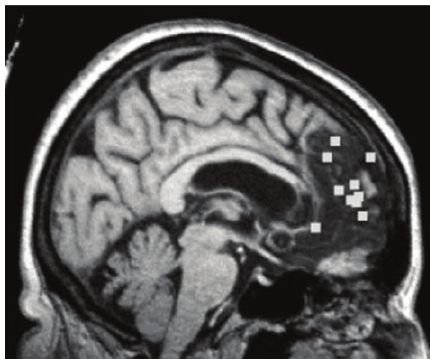
Figure 3: Figure from Bird et al., 2004, showing the lesion site of a patient with anterior cingulate damage who did not show theory of mind impairments. Peak activation foci related to theory of mind from ten di ff erent neuroimaging studies are shown (boxes) superimposed onto the lesion site. The figure shows that a lesion in the region of the anterior cingulate activated by theory of mind tasks does not cause impairments on these tasks (reprinted with permission from